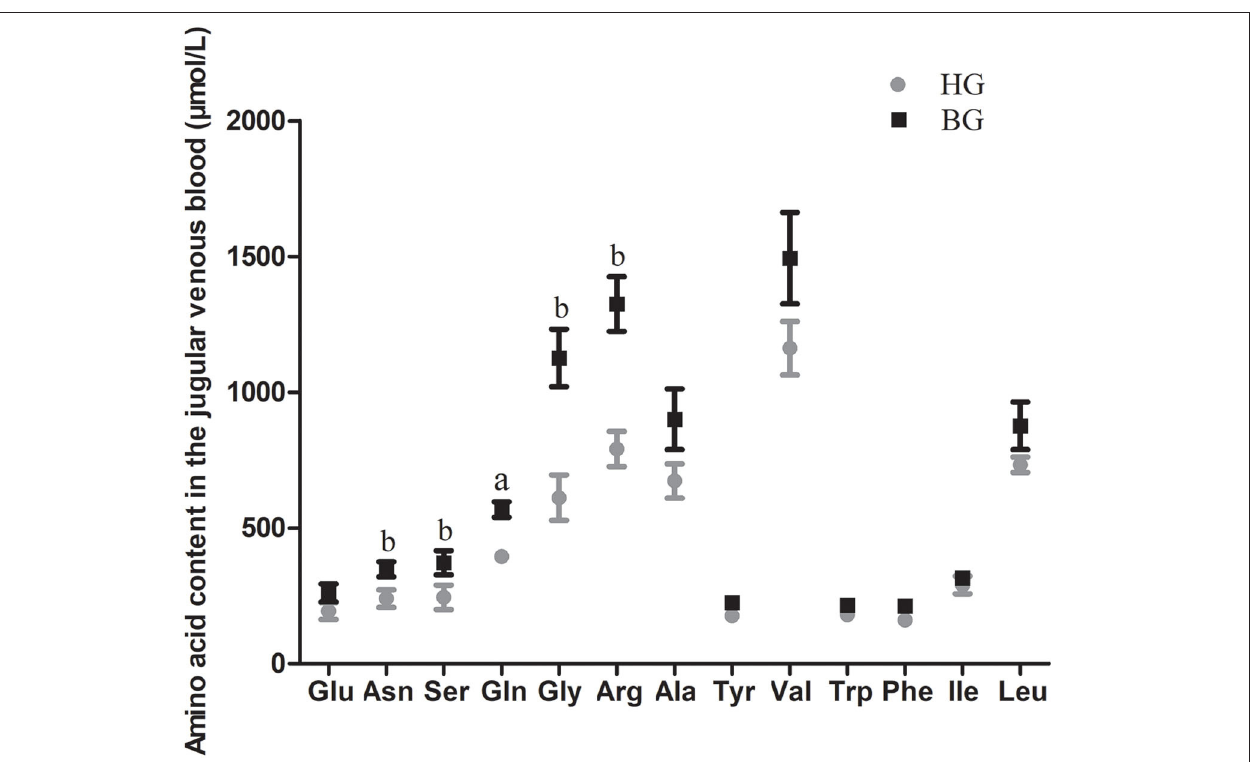
FIGURE 2 | Impact of high-grain diet with buffering agent on amino acid content in plasma of lactating goats. Values are mean ± SEM, n = 6/group. b p < 0.05 and a p < 0.01, compared with high grain group.